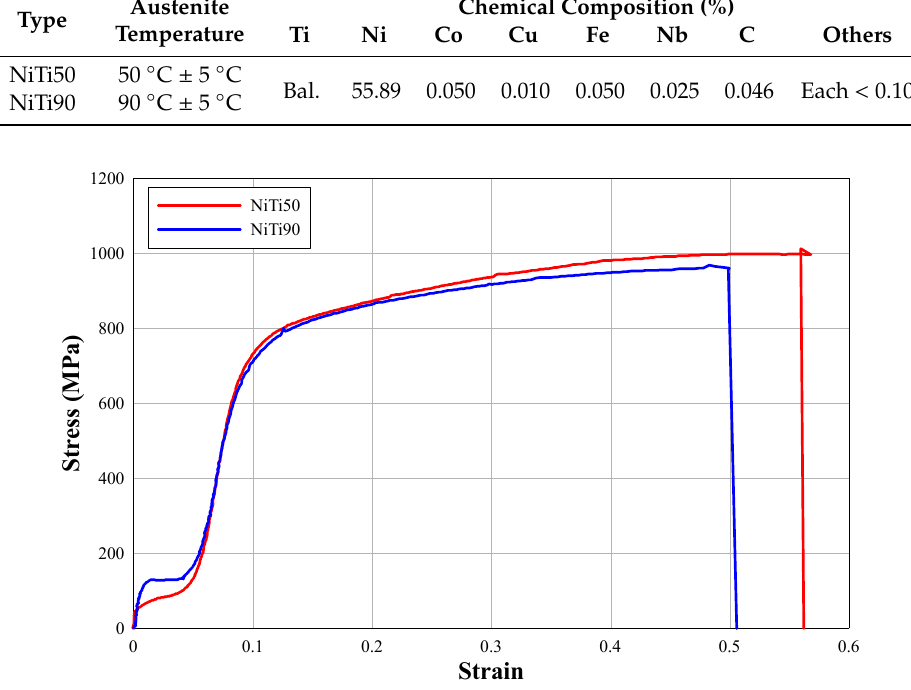
Figure 3. Stress-strain curves of SMA wires.